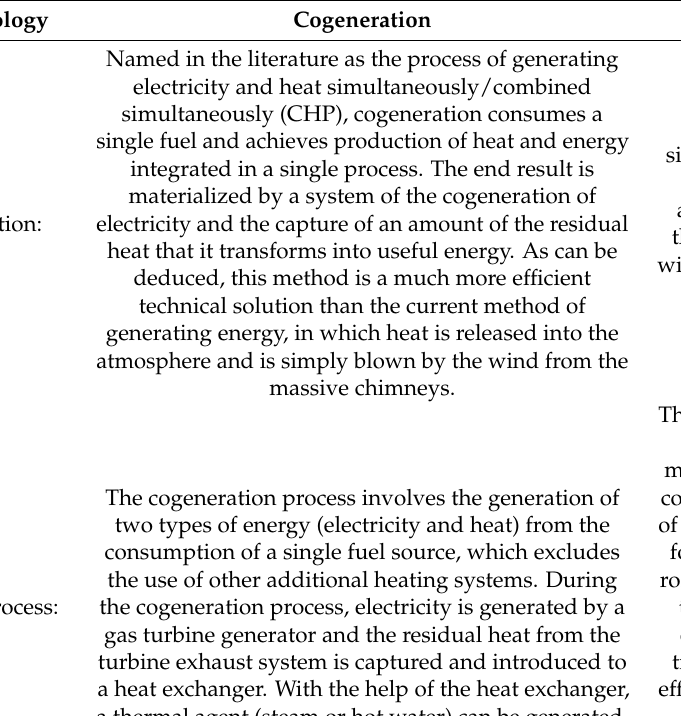
Table 4. Cogeneration vs.